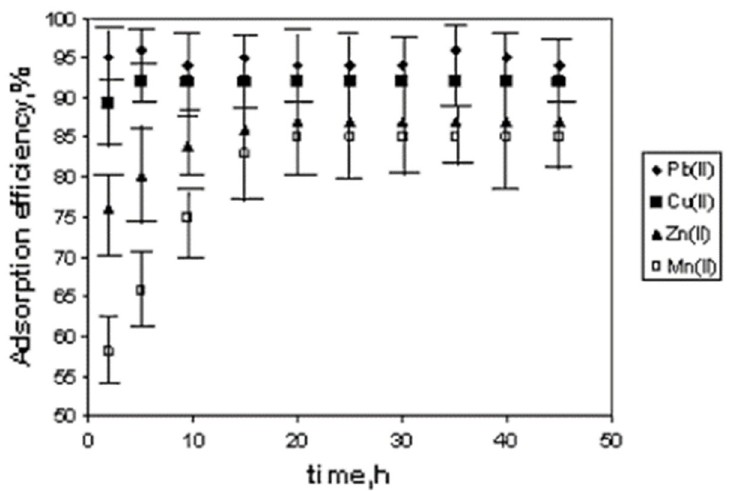
Figure 3. Effect of contact time on the adsorption of Pb 2+ , Mn 2+ , Cu 2+ and Zn 2+ ions using magnetic Fe 3 O 4 nanoparticles. T = 298 K, pH 5.5, adsorbent dosage = 200 mg, Vsolution = 50 mL, Initial metal ions concentration = 150 mg/L. Adapted with permission from [184].